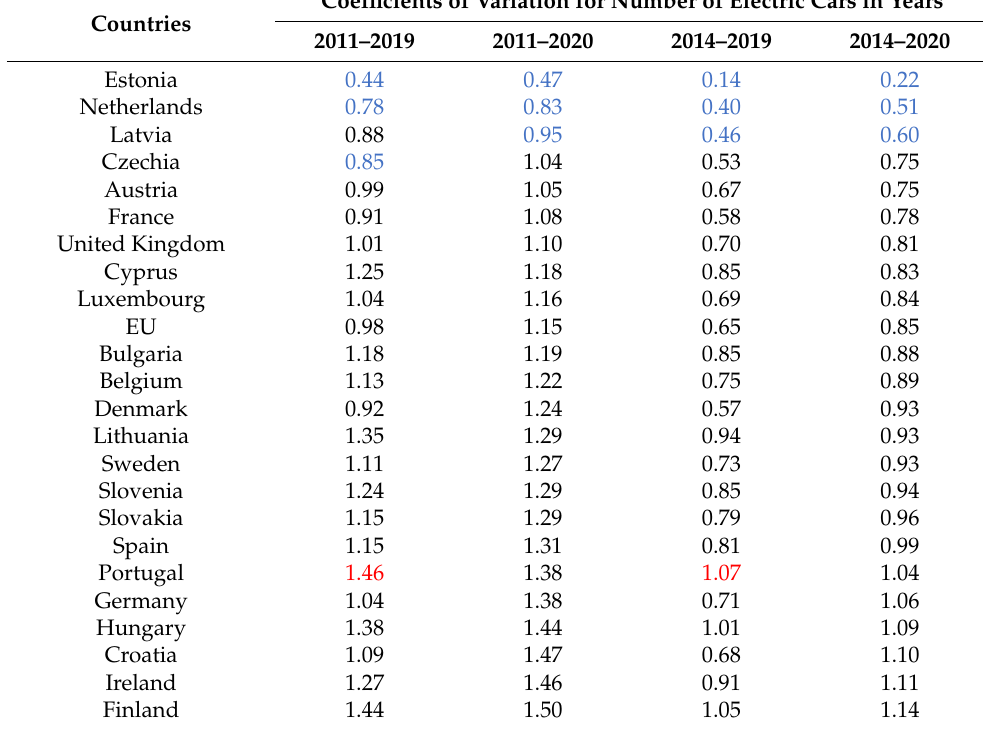
Table 4. Coefficients of variation for the number of electric cars in EU countries in 2011–2020. Coefficients of Variation for Number of Electric Cars in Countries